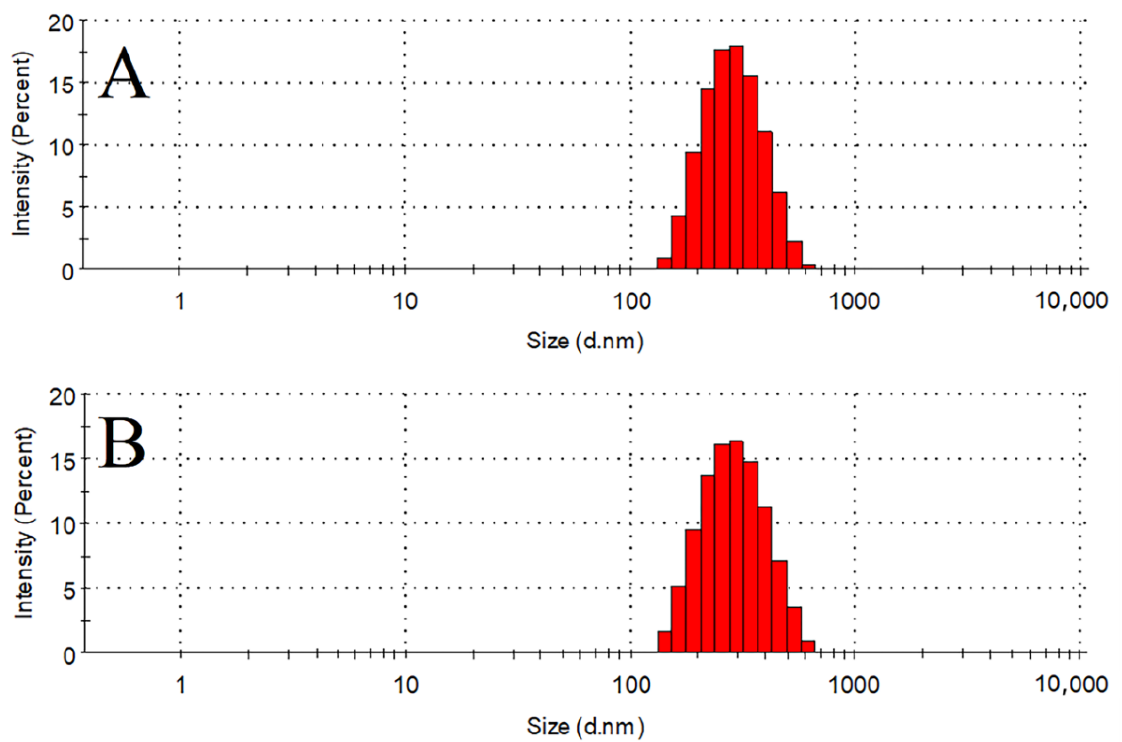
Figure 3. Particle size distribution of Bre-NS ( A ) and Bre-NS freeze-dried powder after redispersion ( B ).